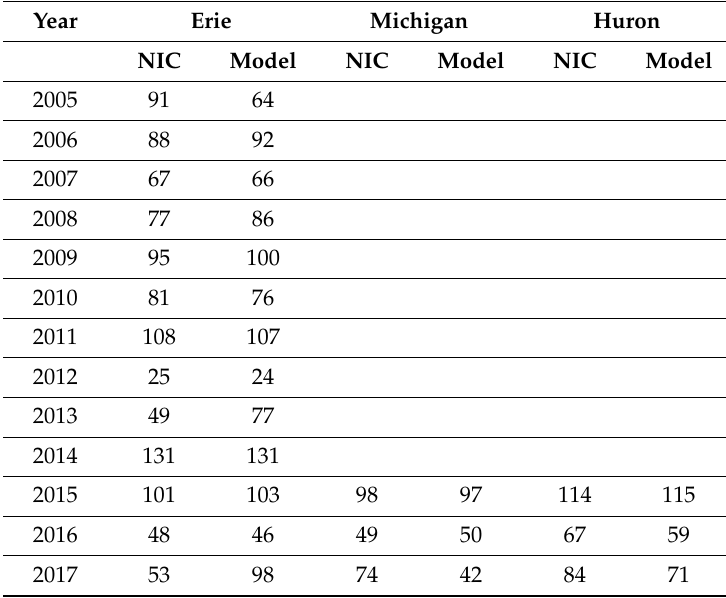
Figure 10. Modeled vs observed ice season duration for all simulated years. The duration is defined as the period of time between ice onset (first day lake-wide extent exceeds 10%) and ice-off (last day extent exceeds 10%). The y-axis shows the length and timing of the ice season by month. Table 3. Ice season length (in days) as defined in Figure